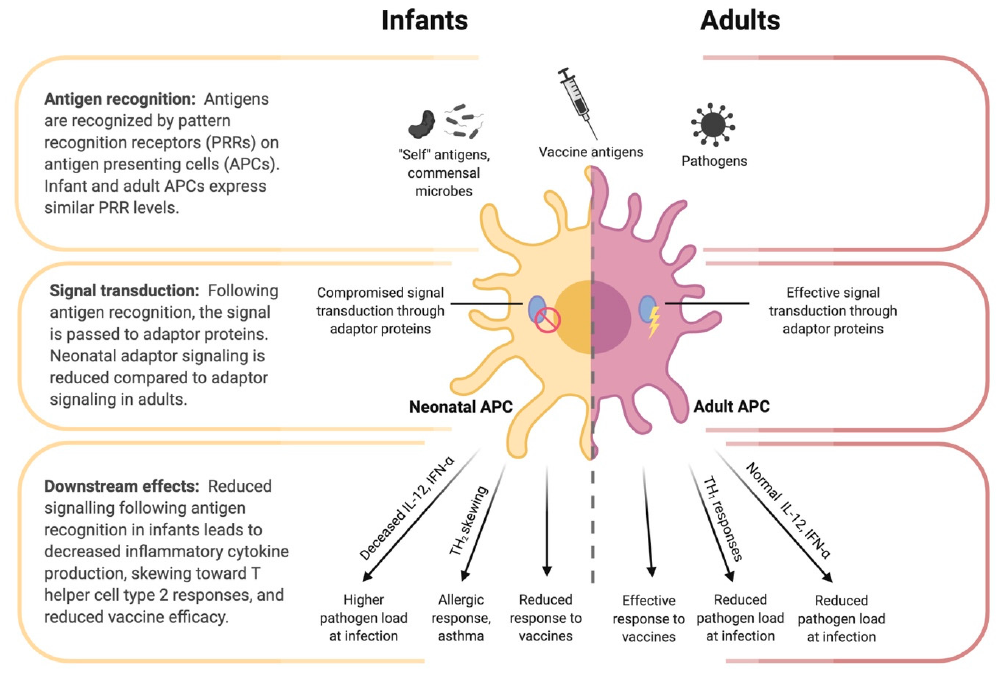
Figure 3. Differences in antigen presenting cell (APC) function between infants and adults. Despite similar pattern recognition receptor (PRR) expression between infant and adult APCs, the downstream signaling following antigen recognition by PRRs differs. Reduced adaptor protein function (e.g., IRF-4) in neonatal APCs contributes to tolerance of self-antigens and commensal microbes, while also reducing responsiveness to pathogens and vaccine antigens, decreased inflammatory cytokine production, and skewing toward a T helper cell type 2 response.